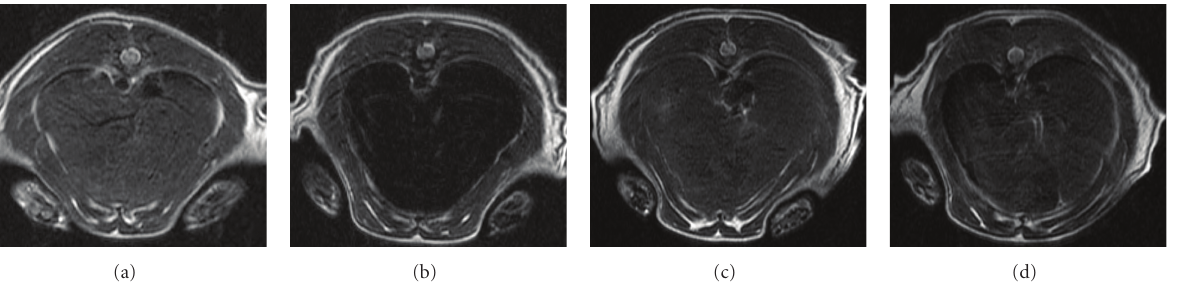
Figure 8: T 2 -weighted MR image (b) after 1-hour injection of PVLA-coated SPIONs shows marked signal drop (darkening) of liver com- pared to T 2 -weighted MR image of preinjection (a). Degree of signal drop is mild between T 2 -weighted MR image of pre- (c) and postinjec- tion (d) of pyrroridone-coated